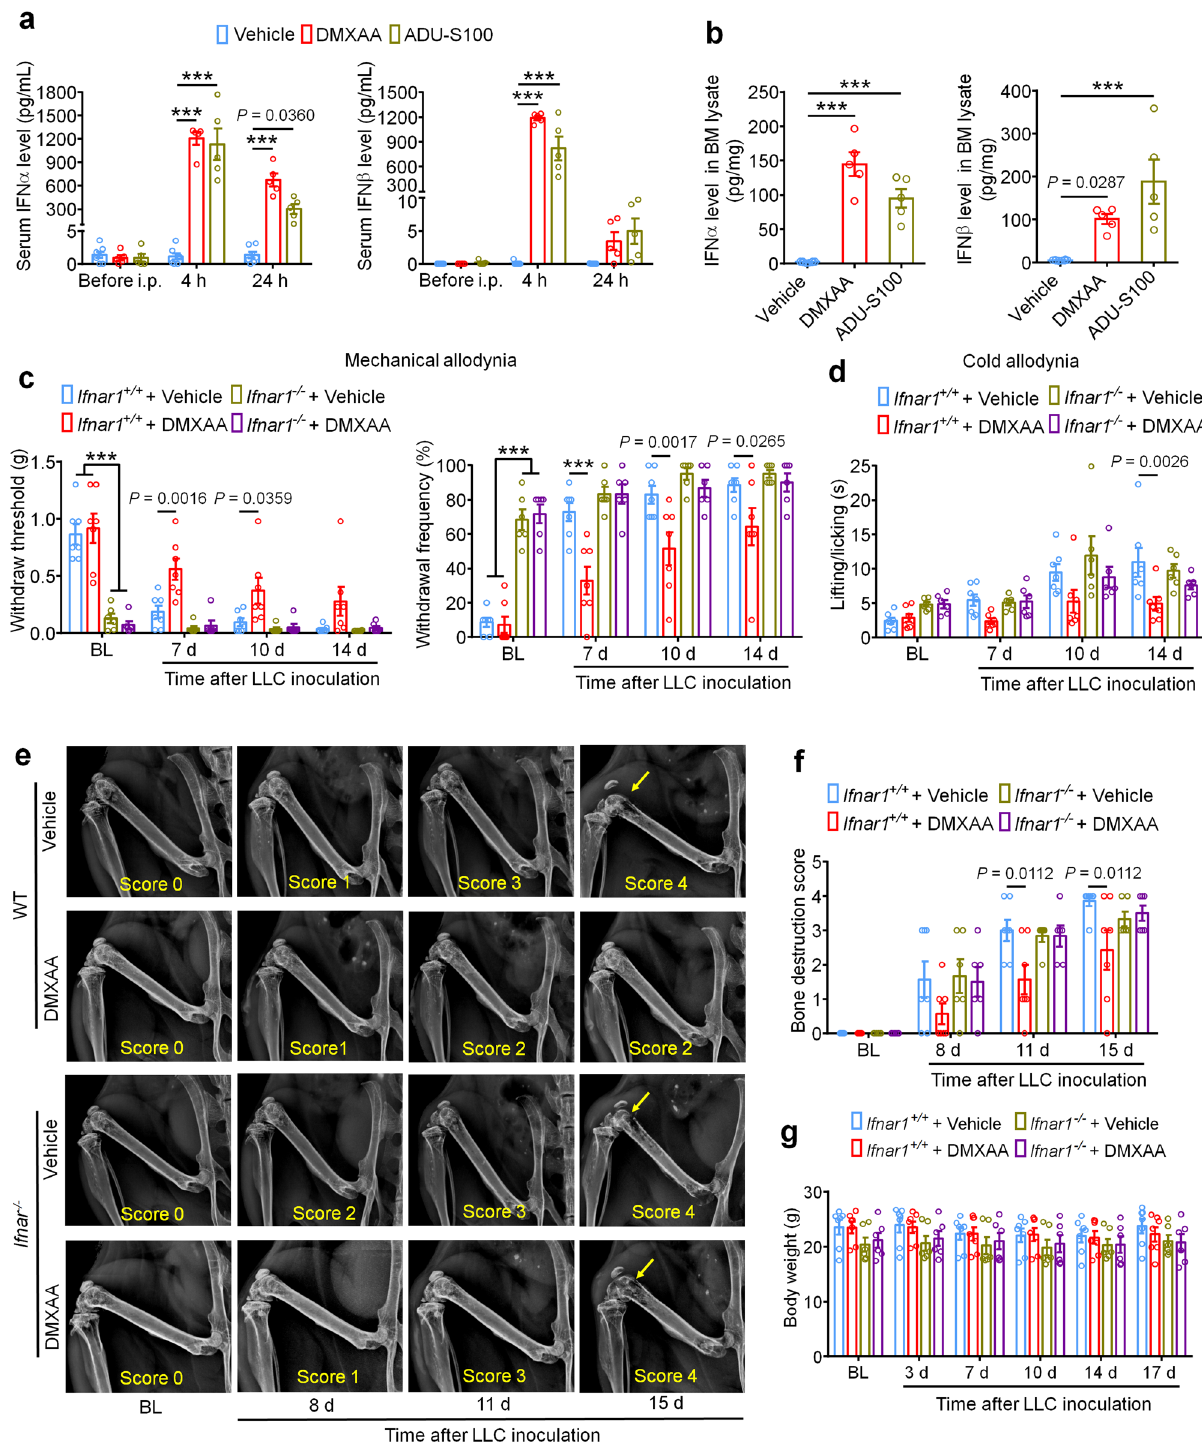
Fig. 3 The protective effects of STING agonists are mediated by host IFN-I signaling. a Analysis of serum IFN- α (left) and IFN- β (right) levels at BL and again 4h or 24h after DMXAA or ADU-S100 treatment on d3 after tumor implantation ( n = 7 vehicle-treated mice, n = 5 DMXAA-treated mice, and n = 5 ADU-S100- treated mice), *** P <0.001. b IFN- α (left) and IFN- β (right) levels in bone marrow (BM) lysates from mice treated with vehicle, DMXAA or ADU-S100 ( n = 8 vehicle-treated mice, n = 5 DMXAA-treated mice, and n = 5 ADU-S100-treated mice), *** P <0.001. c von Frey testing to determine withdrawal threshold (left) and frequency (right) from Ifnar1 + / + or Ifnar1 − / − mice treated with vehicle or DMXAA (2 x 20mg/kg, i.p.). d Analysis of cold allodynia in vehicle or DMXAA- treated Ifnar1 + / + mice and Ifnar1 − / − mice. e – f Bone destruction scores from radiographs of tumor bearing femora in Ifnar1 + / + and Ifnar1 − / − mice with the indicated treatment on d0, d8, d11 and d15 after LLC injection. Arrows show bone lesions with destruction scores over 3. e Representative X-ray images. f Quanti fi cation for e . g Body weight measurement after vehicle or DMXAA treatment. Sample sizes for c – g were as follows: n = 7 vehicle-treated Ifnar1 + / + mice, n = 7 DMXAA-treated Ifnar1 + / + mice, n = 6 vehicle-treated Ifnar1 − / − mice, n = 6 DMXAA-treated Ifnar1 − / − mice. All data indicate the mean ± SEM, repeated-measures two-way ANOVA with Bonferroni ’ s post-hoc test ( a , c , d , f , g ); one-way ANOVA with Bonferroni ’ s post-hoc test ( b ). Source data are provided as a Source Data fi le. NATURE COMMUNICATIONS| (2021) 12:4558